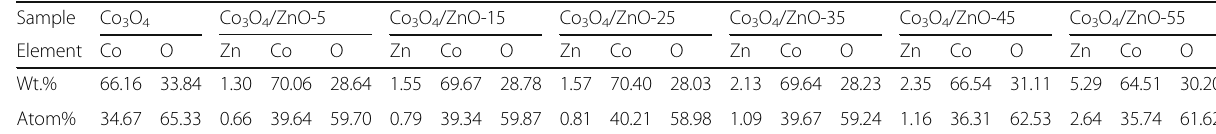
Table 1 Weight and atomic percentages of elements in Co 3 O 4 nanoparticles and Co 3 O 4 /ZnO heterostructures detected by EDX Sample Co 3 O